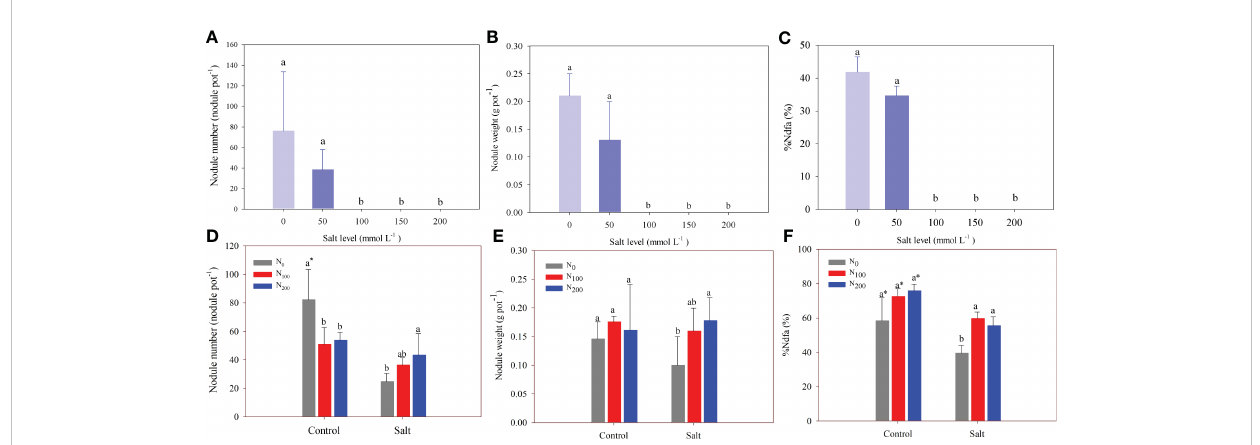
FIGURE 5 Alfalfa nodule number (A) , nodule weight (B) , and nitrogen derived from the atmosphere (%Ndfa) (C) in different salt levels in experiment 1. Alfalfa nodule number (D) , nodule weight (E) , and %Ndfa (F) in different nitrogen (N) supply and salt levels in experiment 2. Error bars represent ± SD of the mean. Different letters represent a signi fi cant difference among treatments ( p ≤ 0.05). Asterisks refer to signi fi cant differences between salt levels at the same N fertilizer supply